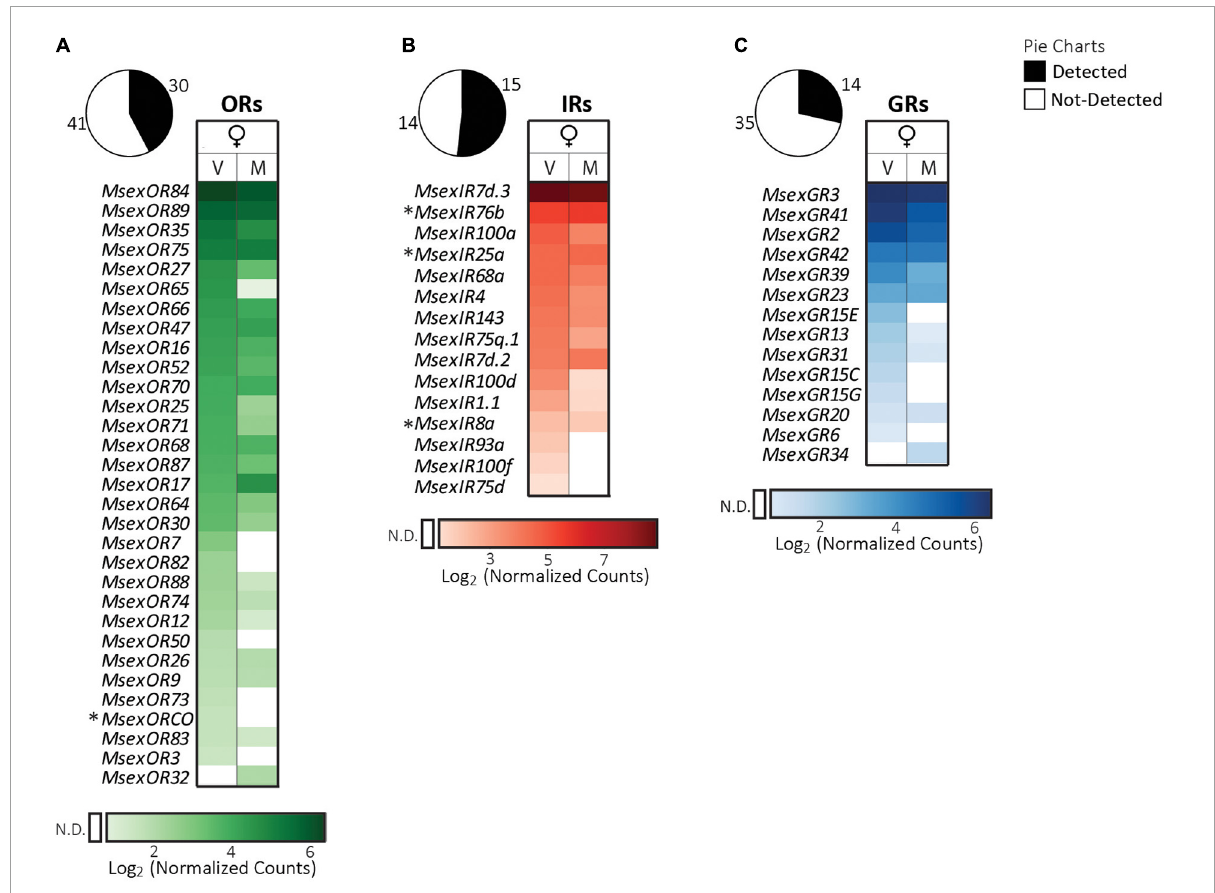
FIGURE5 Expression of chemosensory receptor genes in the ovipositor of female adult M. sexta . (A) Odorant receptors, (B) ionotropic receptors, (C) gustatory receptors. Pie charts depict the percentage of expressed genes (absolute numbers next to the charts) of each receptor family (see legend on top right). Heatmaps were created separately for each receptor family using the log 2 of the geometric mean ( n = 3 biological replicates) of normalized counts obtained from the NanoString assay (see section “Materials and methods”). Light to dark shades indicate low to high counts (see color bar at bottom of each heatmap); white cells indicate no detection (N.D.) of transcripts (for a definition see section “Materials and methods”). Columns represent female moths of different mating states (V: virgin, M: mated). Rows represent receptors that were expressed in the ovipositor of at least one of the two groups, and are sorted first according to values in virgin females, followed by mated females. Symbols next to receptor gene names: ∗ , OR or IR co-receptors. Mating state of females did not have a significant effect on receptor gene expression (FDR corrected p > 0.05, nested